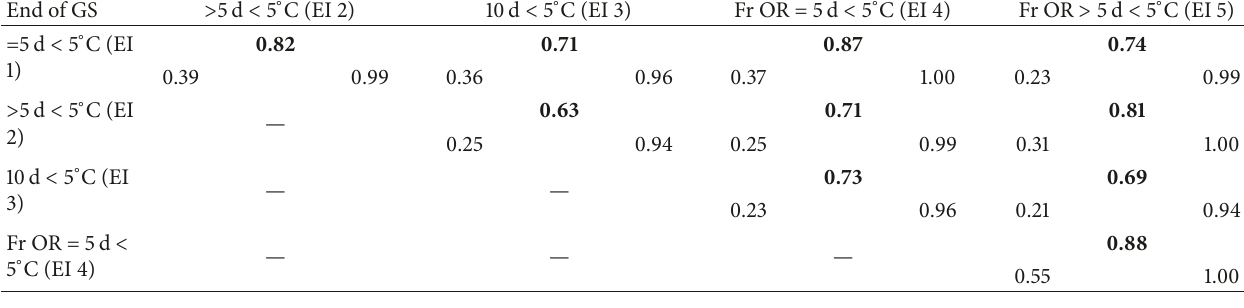
Table 3: Correlation coefficients for combinations of the end indices of growing season. Single bold values show the mean coefficients over northern China, and the paired values below show the minimum (left) and maximum (right) coefficients.